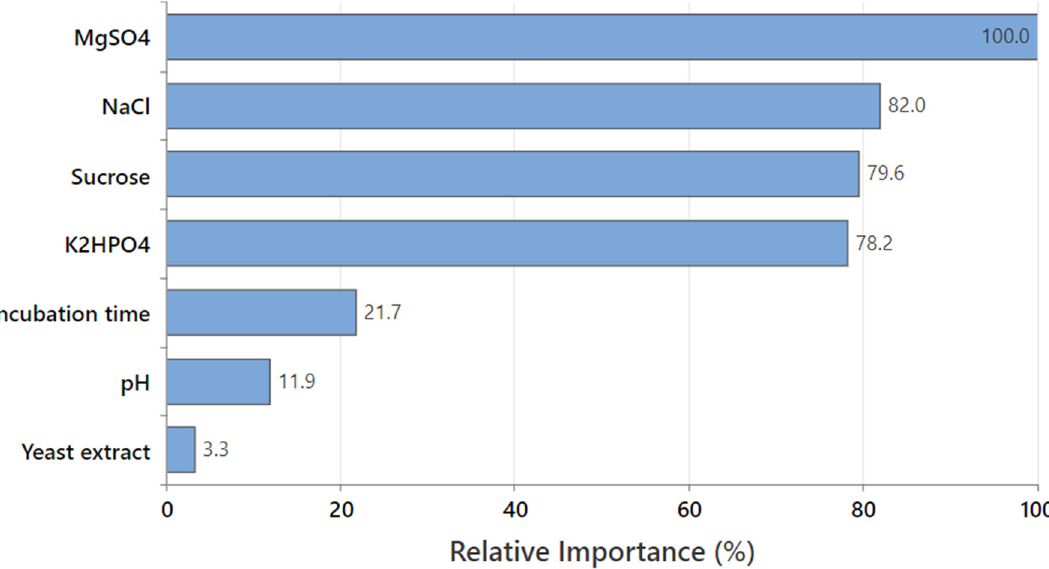
Figure 7. The relative importance of the seven tested factors on pullulan production based on the decision tree learning algorithm.